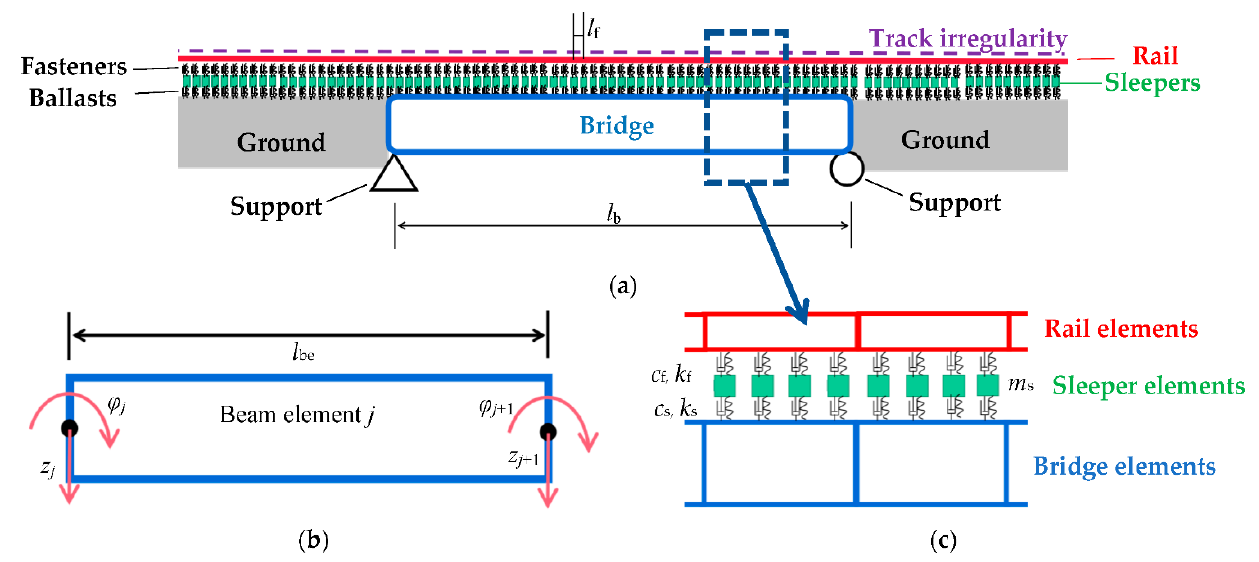
Figure 3. 2D model of track–bridge subsystem: ( a ) Global view of 2D model of track–bridge subsys- tem; ( b ) Beam element j; ( c ) Local view of track–bridge subsystem. Table 2. Parameter values of track–bridge subsystem